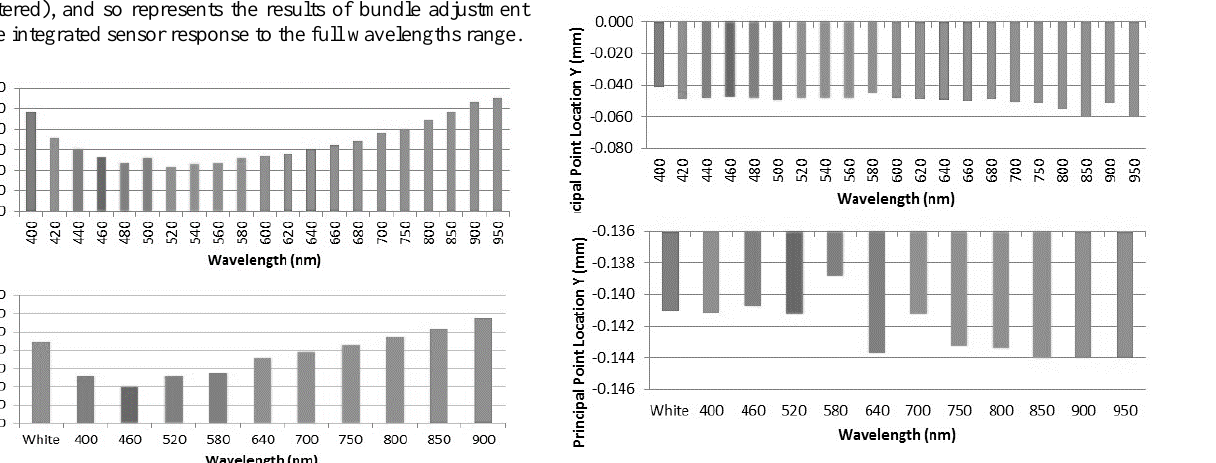
Figure 9. Variation in Principal Point (Y) with